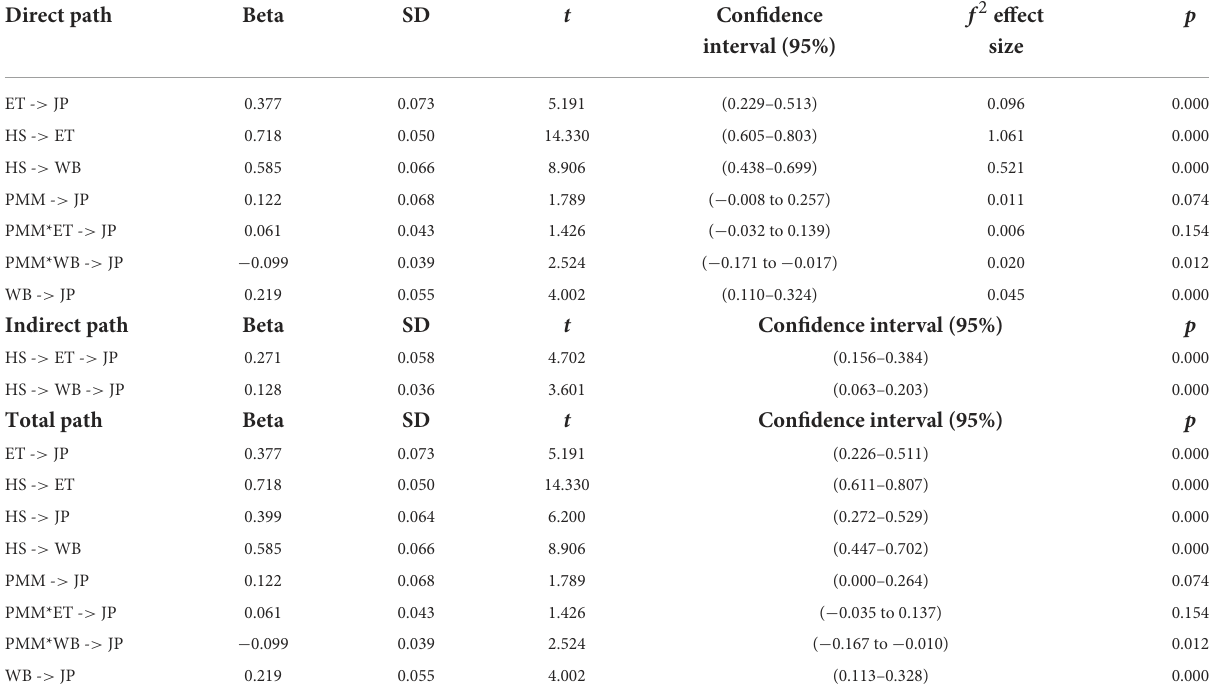
TABLE 4 Direct, indirect, and total path estimates.